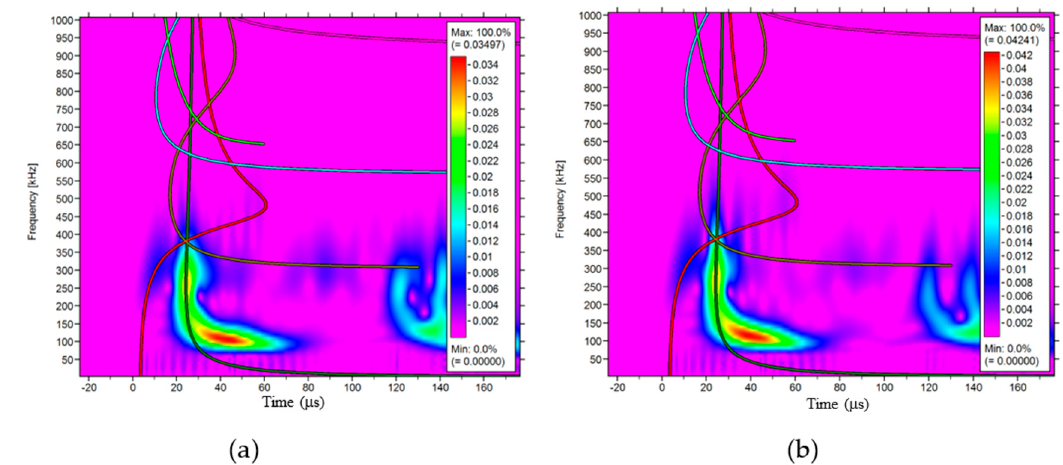
Figure 7. Wavelet transform of AE sensor ( a ) ch.1 and ( b ) ch.2.